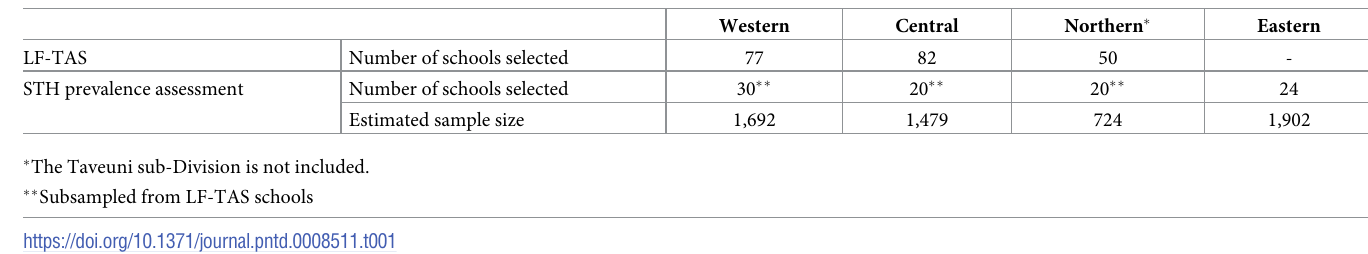
Table 1. Number of selected schools and estimated sample sizes for the STH prevalence assessment in the 4 Divisions of Fiji, 2014–2015